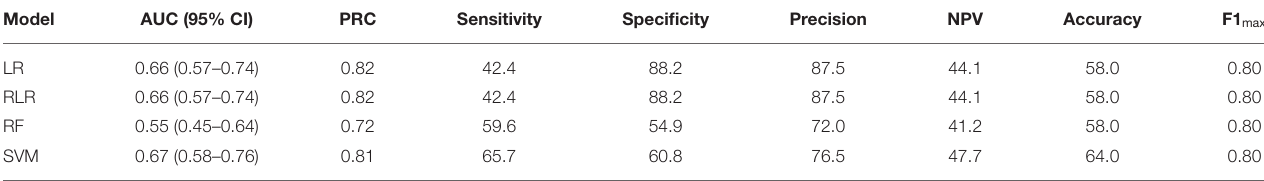
TABLE 5 | Scores for each algorithm of model 1 in external validation cohort. Model